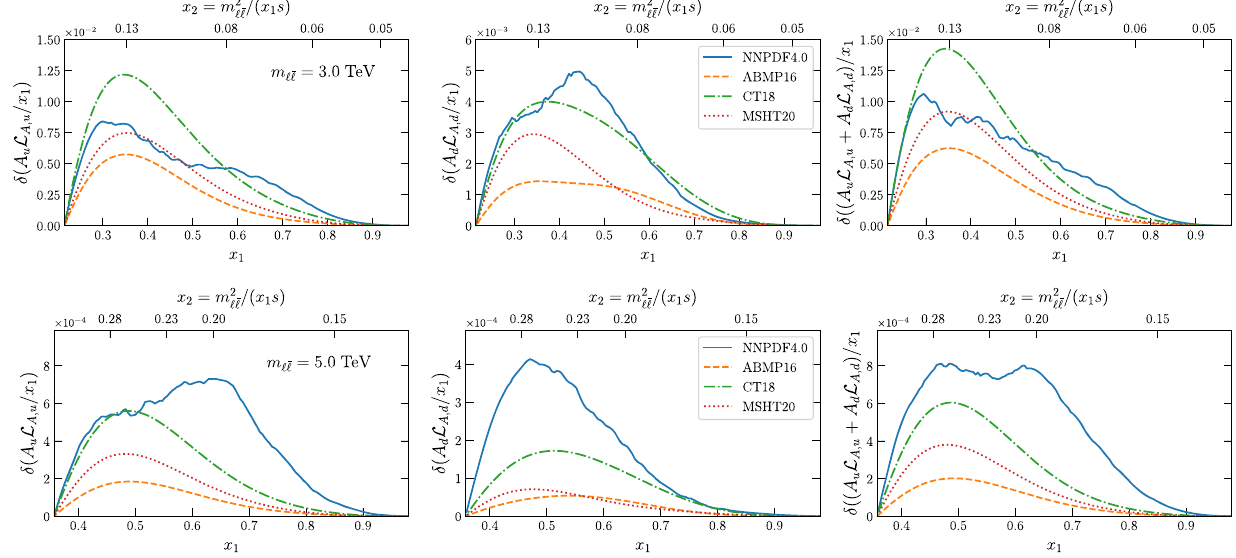
Fig. 14 Same as Fig. 13 now for the absolute PDF uncertainties